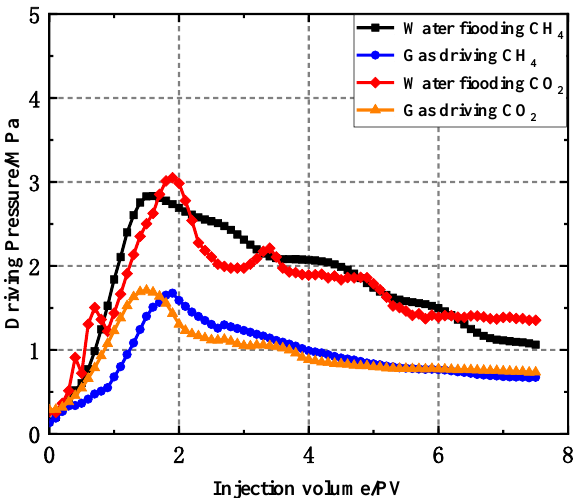
Figure 16. Test results of plugging with different gases under gas–liquid co-injection.